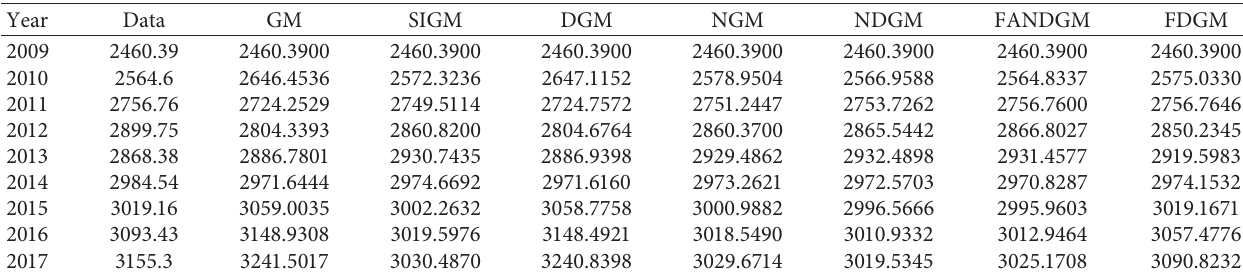
Figure 12: Results of energy consumption of civil building in Beijing. Table 6: Fitting results and prediction results of energy consumption of civil building in